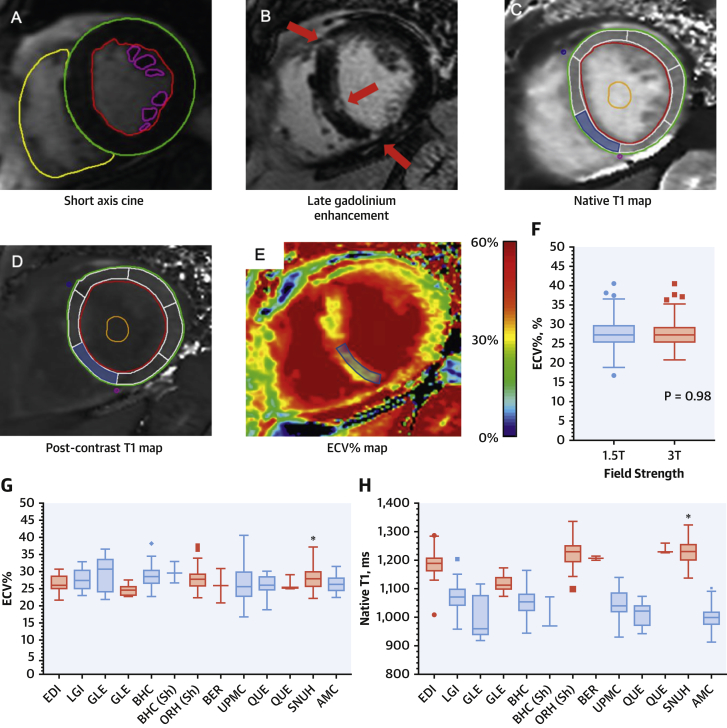
Multiparametric CMR AssessmentCardiovascular magnetic resonance (CMR) short-axis cine images were contoured to provide ventricular volumes, mass, and ejection fraction (A). Areas of late gadolinium enhancement (B, red arrows) were quantified using the full-width-at-half-maximum technique. Native (C) and post-contrast (D) T1 maps were analyzed, and the mean value from segment 9 (shaded blue) and blood pool (orange contour) were used to calculate the extracellular volume fraction (ECV%). ECV% values did not vary by field strength (p = 0.98) (F), and minimal variation in ECV% values was observed across the different centers (G). By contrast, native T1 values varied significantly by center (H), mainly due to the effect of magnetic field strength (blue = 1.5-T, red = 3.0-T). Contour legend: red = left ventricular endocardial; green = left ventricular epicardial; yellow = right ventricular endocardial; purple = papillary muscle; orange = blood pool region of interest; blue = myocardial (segment 9) region of interest. AMC = Asan Medical Center, Seoul, Korea; BER = Berlin, Germany; BHC = Barts Heart Centre, London, United Kingdom; EDI = Edinburgh, United Kingdom; GLE = Leicester, United Kingdom; LGI = Leeds, United Kingdom; ORH = Oxford, United Kingdom; QUE = Québec, Canada; Sh = ShMOLLI T1 mapping sequence used; SNUH = Seoul National University Hospital, Seoul, Korea; UPMC = Pittsburgh, Pennsylvania.